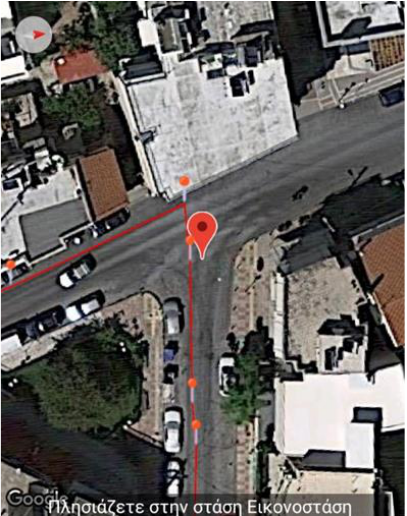
Figure 6. The application issues the instruction “Approaching Eikonostasi bus stop”. Finally, when the blind user has reached the intended destination, the app alerts him/her to exit the bus (see Figure